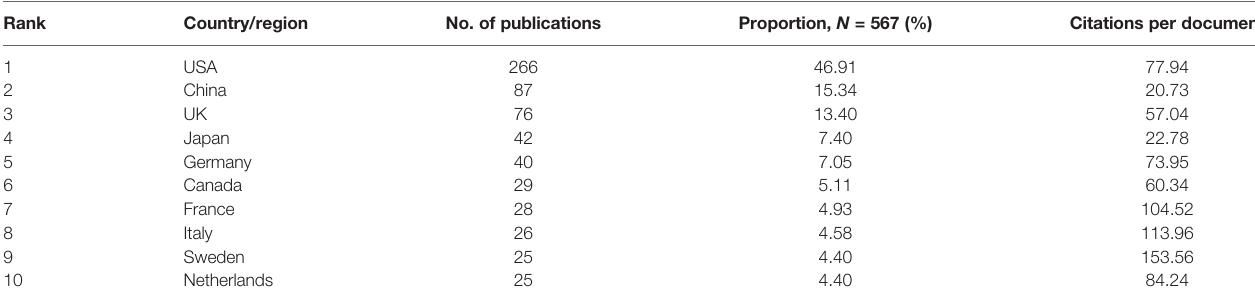
TABLE 1 | Top 10 countries/regions contributing to publications on genome-wide association study (GWAS) in diabetes. Rank Country/region No. of publications Proportion, N = 567 (%) Citations per